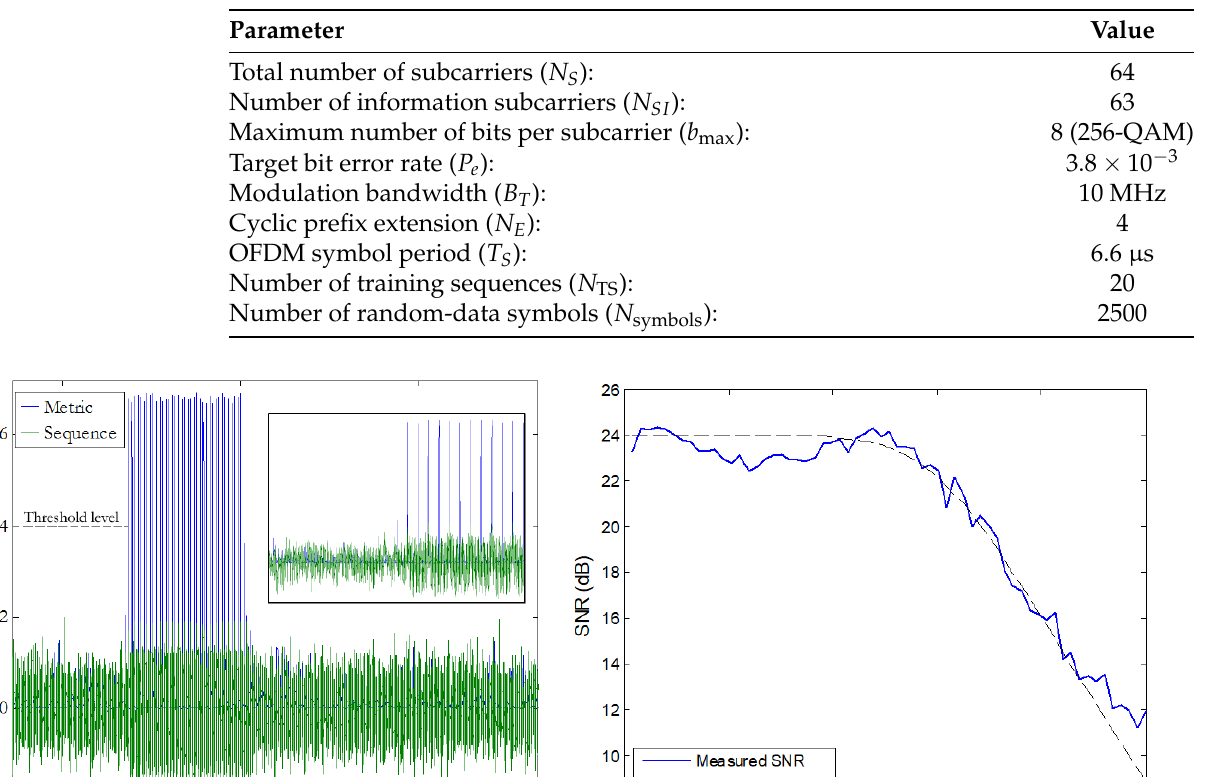
Table 3. Parameters for Adaptive OFDM System.